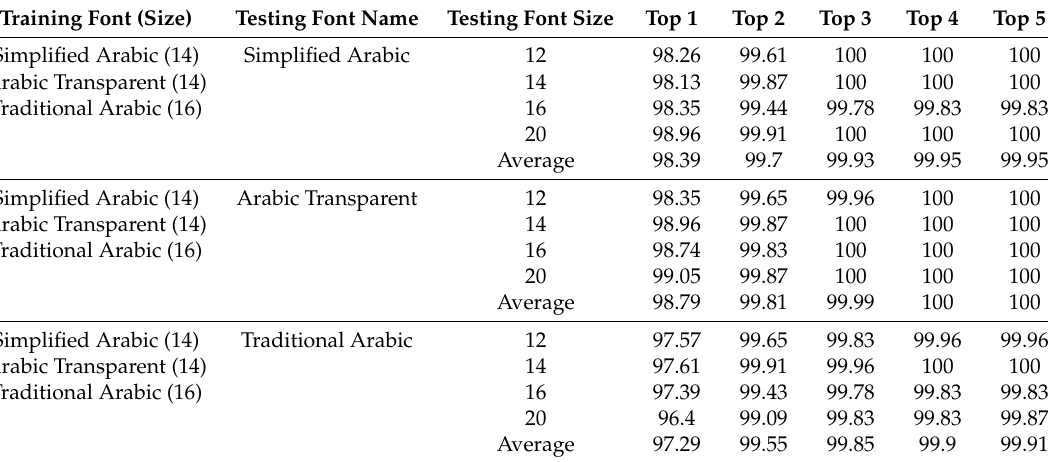
Table 3. Multi-Fonts WRR (percent) for multi size fonts (12, 14, 16 and 20).